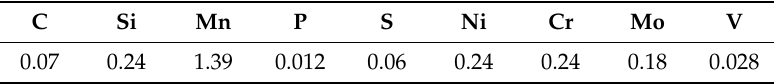
Table 2. Chemical compositions of 07MnNiCrMoV steel (wt. %).